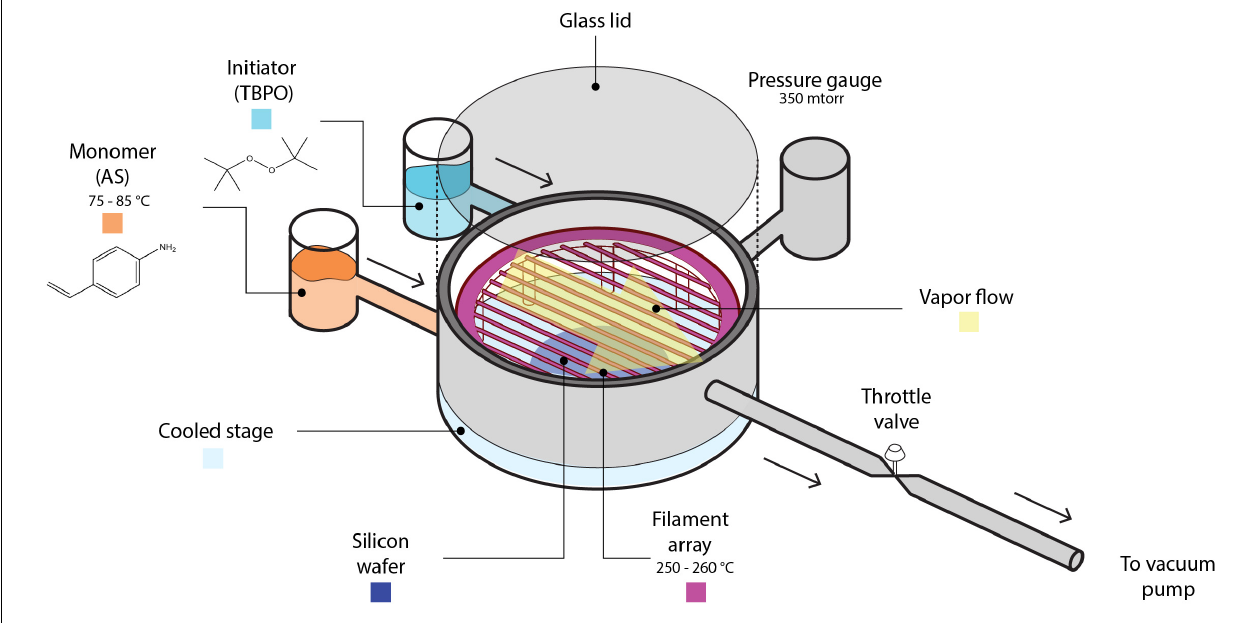
FIGURE 1 | The schematic of initiated Chemical Vapor Deposition